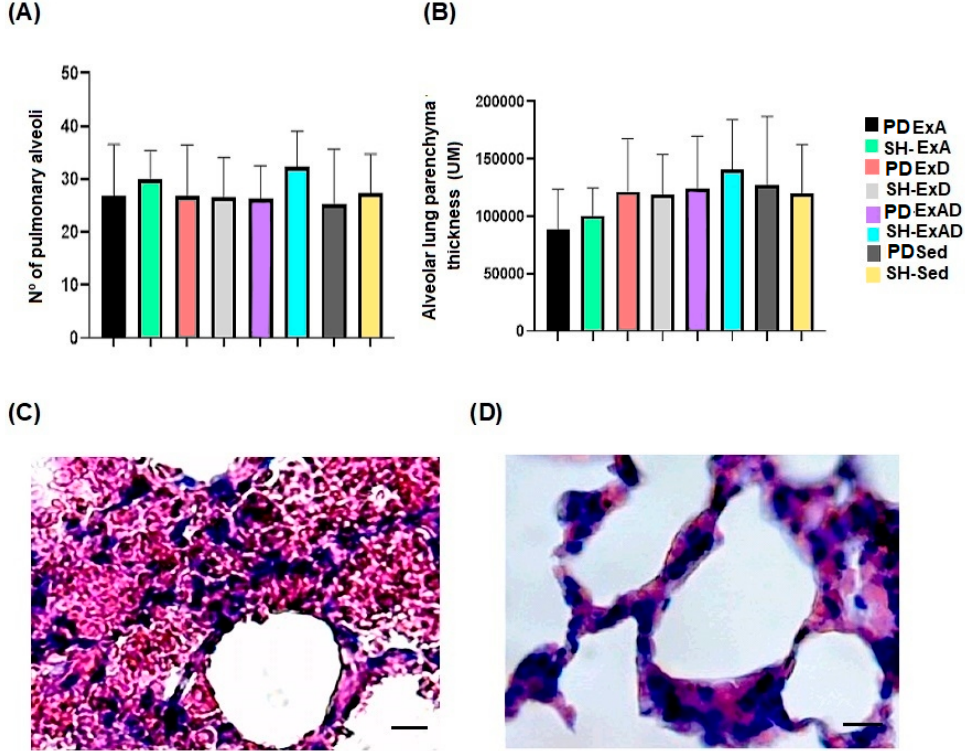
Figure 3. Lung Tissue Analysis. ( A ) Mean number of pulmonary alveoli. ( B ) Mean lung parenchyma thickness in the animal groups. ( C ) Photomicrographs of the lung parenchyma. ( D ) Photomicrograph of alveolar wall thickness (400× magnification).